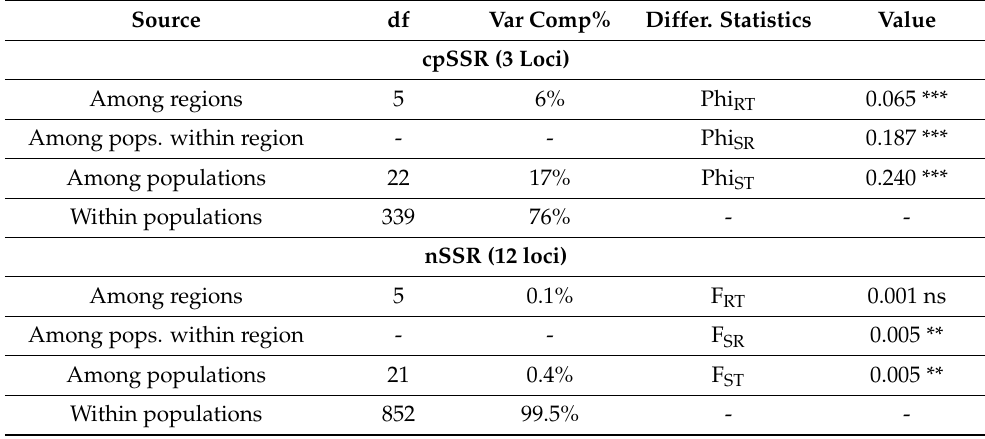
Table 2. AMOVA analysis for the nSSR and cpSSR datasets. Phi is the differentiation index based on F ST -like genetic distances for haploid